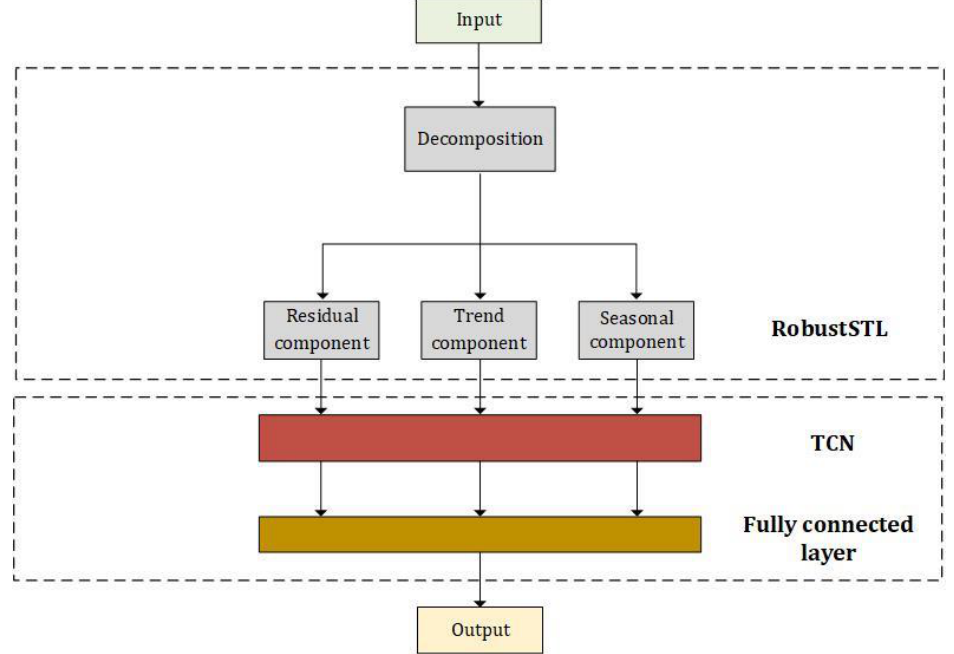
Figure 1. The general architecture of the proposed method.